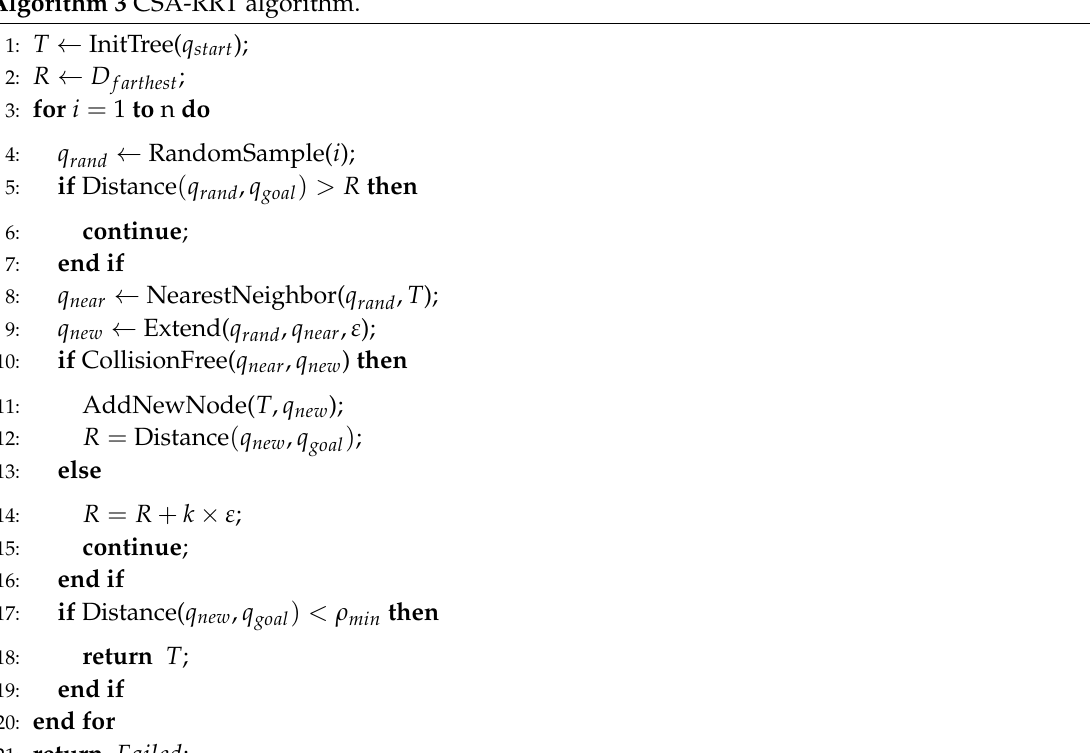
Algorithm 3 CSA-RRT